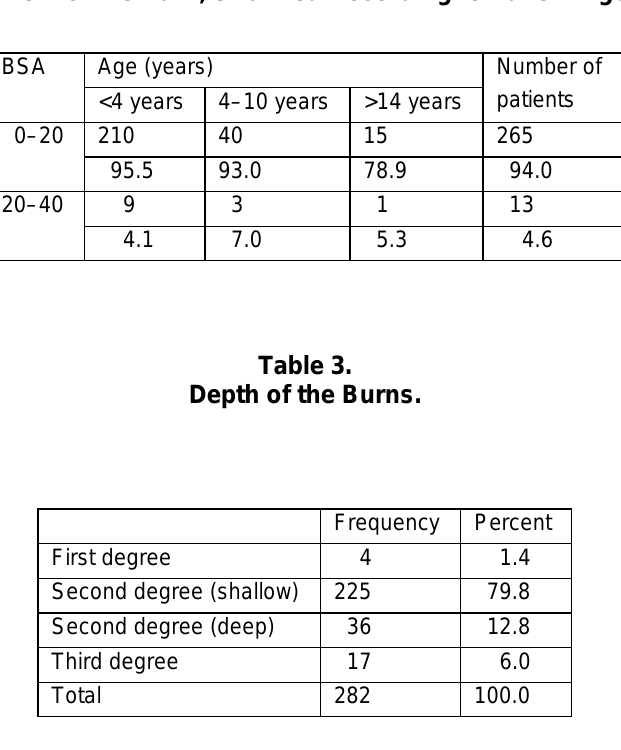
Extent of the Burn, Stratified According to Patient Age